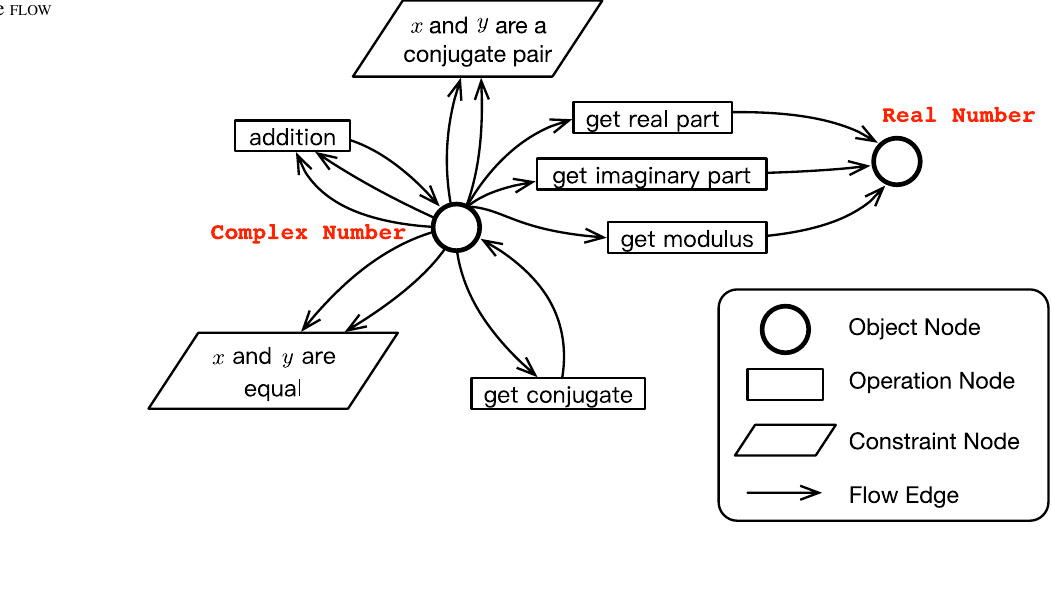
Fig. 2 Example of the flow edges